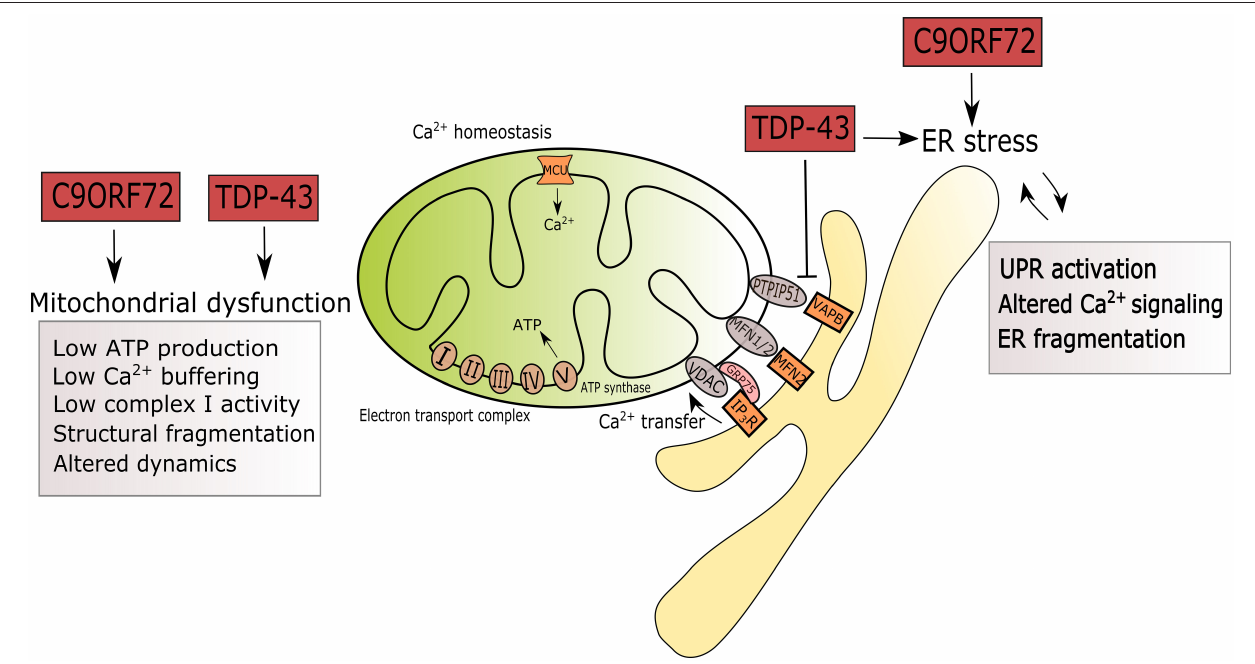
FIGURE 1 | Summary of ER and mitochondrial alterations induced by mutations in C9ORF72 and TARDBP in the context of ALS. ALS-associated mutations in C9ORF72 and TARDBP are triggers of ER stress by UPR activation, altered Ca 2 + signaling and fragmentation of the ER network. Mutant TDP-43 disrupts the tethering of PTPIP5 and VAPB. In mitochondria, mutations in C9ORF72 and TARDBP associate with reduced ATP production, Ca 2 + signaling, complex I activity, leading to structural fragmentation and reduced mitochondrial transport in